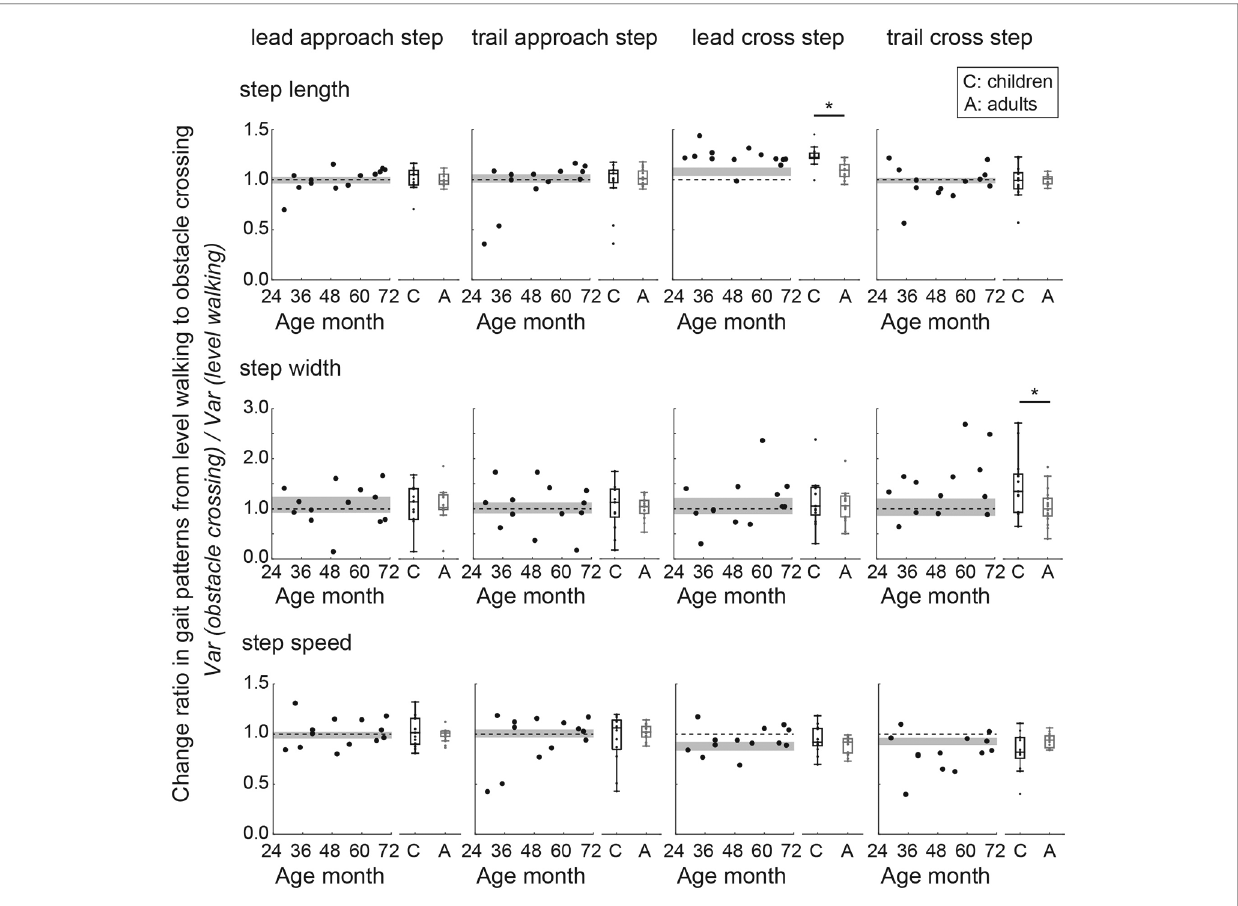
FIGURE 8 Change ratios of the step length, step width, and step speed from level walking to obstacle crossing. A ratio value greater than 1 indicates that the gait parameter during obstacle crossing was greater than that during level walking. Circles indicate the mean value of within participants. The gray area shows the 95% con fi dence interval (CI) of the mean of adults. The dotted line indicates a change ratio equal to 1. * Indicates p